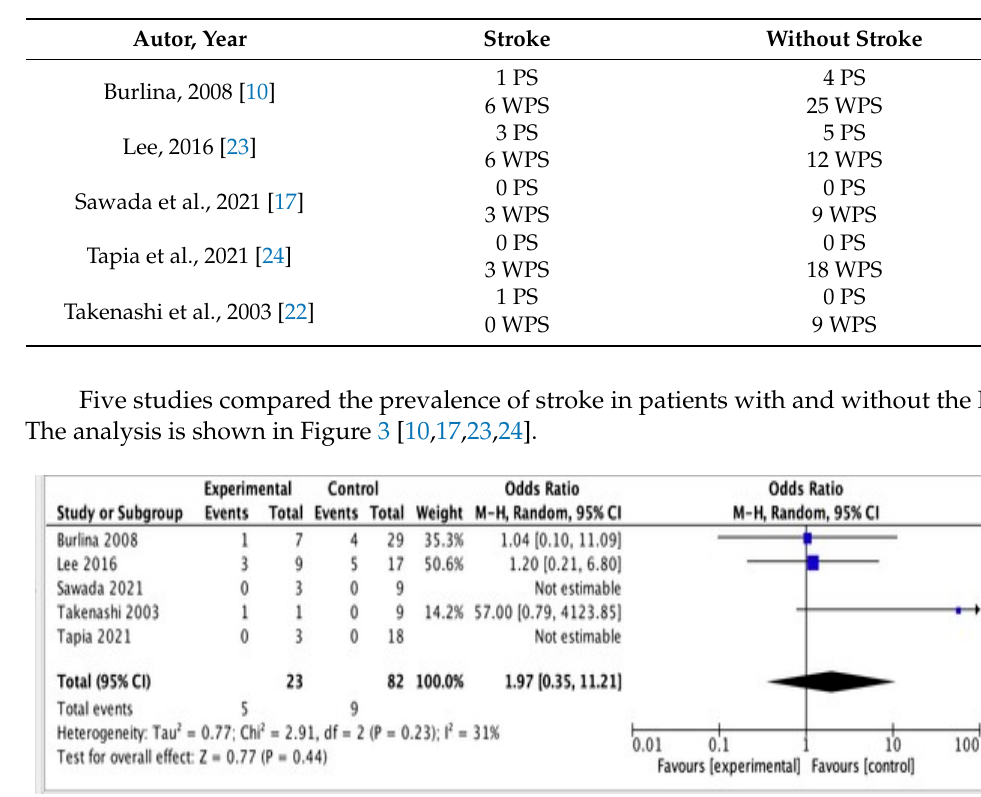
Table 2. Shows the frequency of stroke in patients with Fabry disease with/without PS—Pulvinar Sign and WPS—Without Pulvinar Sign.